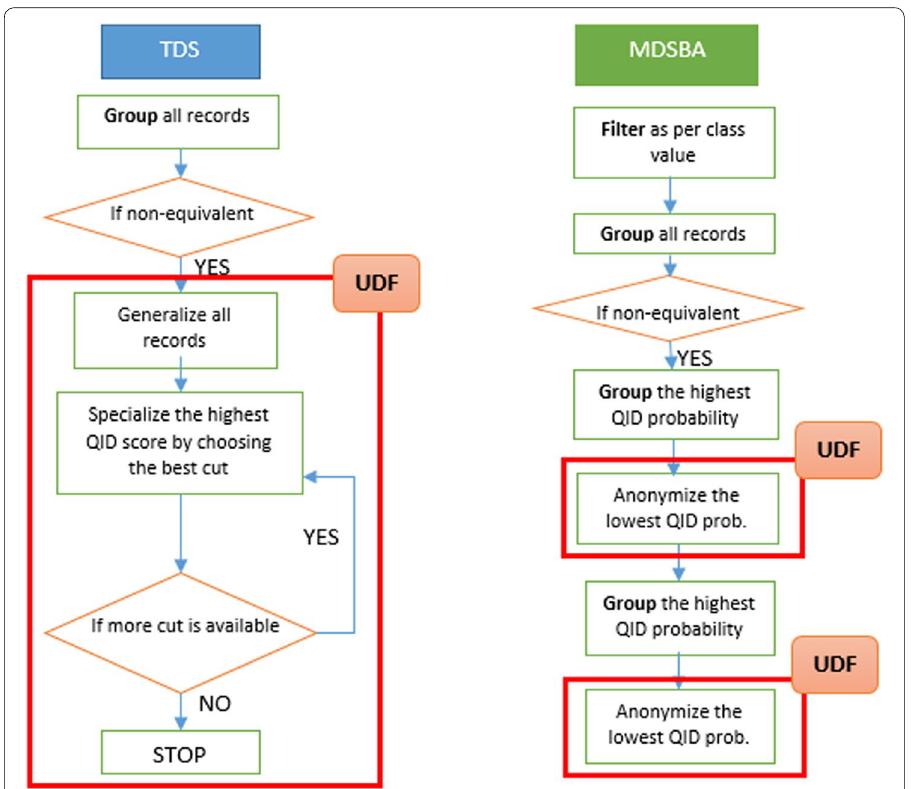
Fig. 3 Comparison between the anonymization algorithms of MDSBA and TDS: MDSBA reduces the dependencies on UDF by reducing the iteration steps. TDS requires many iterations to determine the